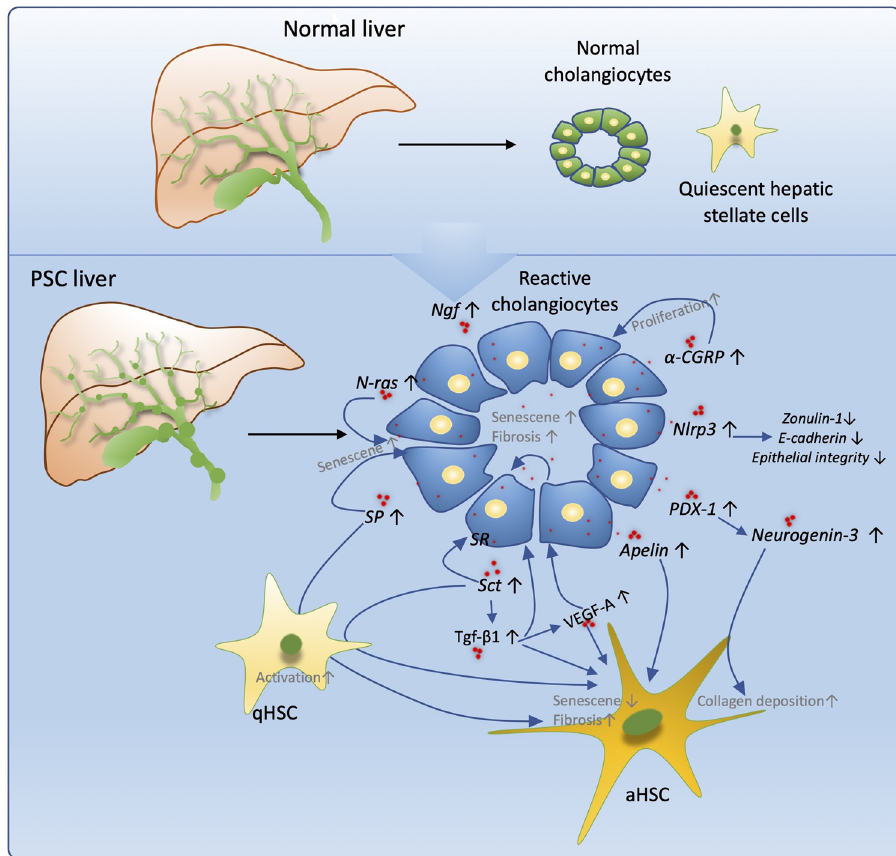
Figure 2: Key factors expressed by reactive cholangiocytes in PSC. In the normal liver, cholangiocytes and HSC stay in normal or quiescent states. In the PSC liver, the cholangiocytes undergo activation and secrete factors, such as secretin, TGF - β 1, VEGF - A, apelin, PDX - 1, Nlrp3, α - CGRP, Ngf, N - Ras, and SP. These factors contribute to senescence or proliferation of cholangiocytes or result in damage to biliary integrity via an autocrine manner. These reactive factors may cause activation of quiescent HSC and decrease HSC senescence but increase fi brosis via collagen deposition. α - CGRP, α - Calcitonin gene - related peptide; Tgf - β 1, Transforming growth factor - β 1; Sct, secretin; SR, secretin receptor; VEGF - A, vascular endothelial growth factor - A; HSCs, hepatic stellate cells; Nlrp3, pyrin domain - containing protein 3; PDX - 1, pancreatic duodenal homeobox protein 1; N - Ras, neuroblastoma Ras. Ngf: nerve growth factor; SP: Substance P. qHSC, quiescent HSC; aHSC, active